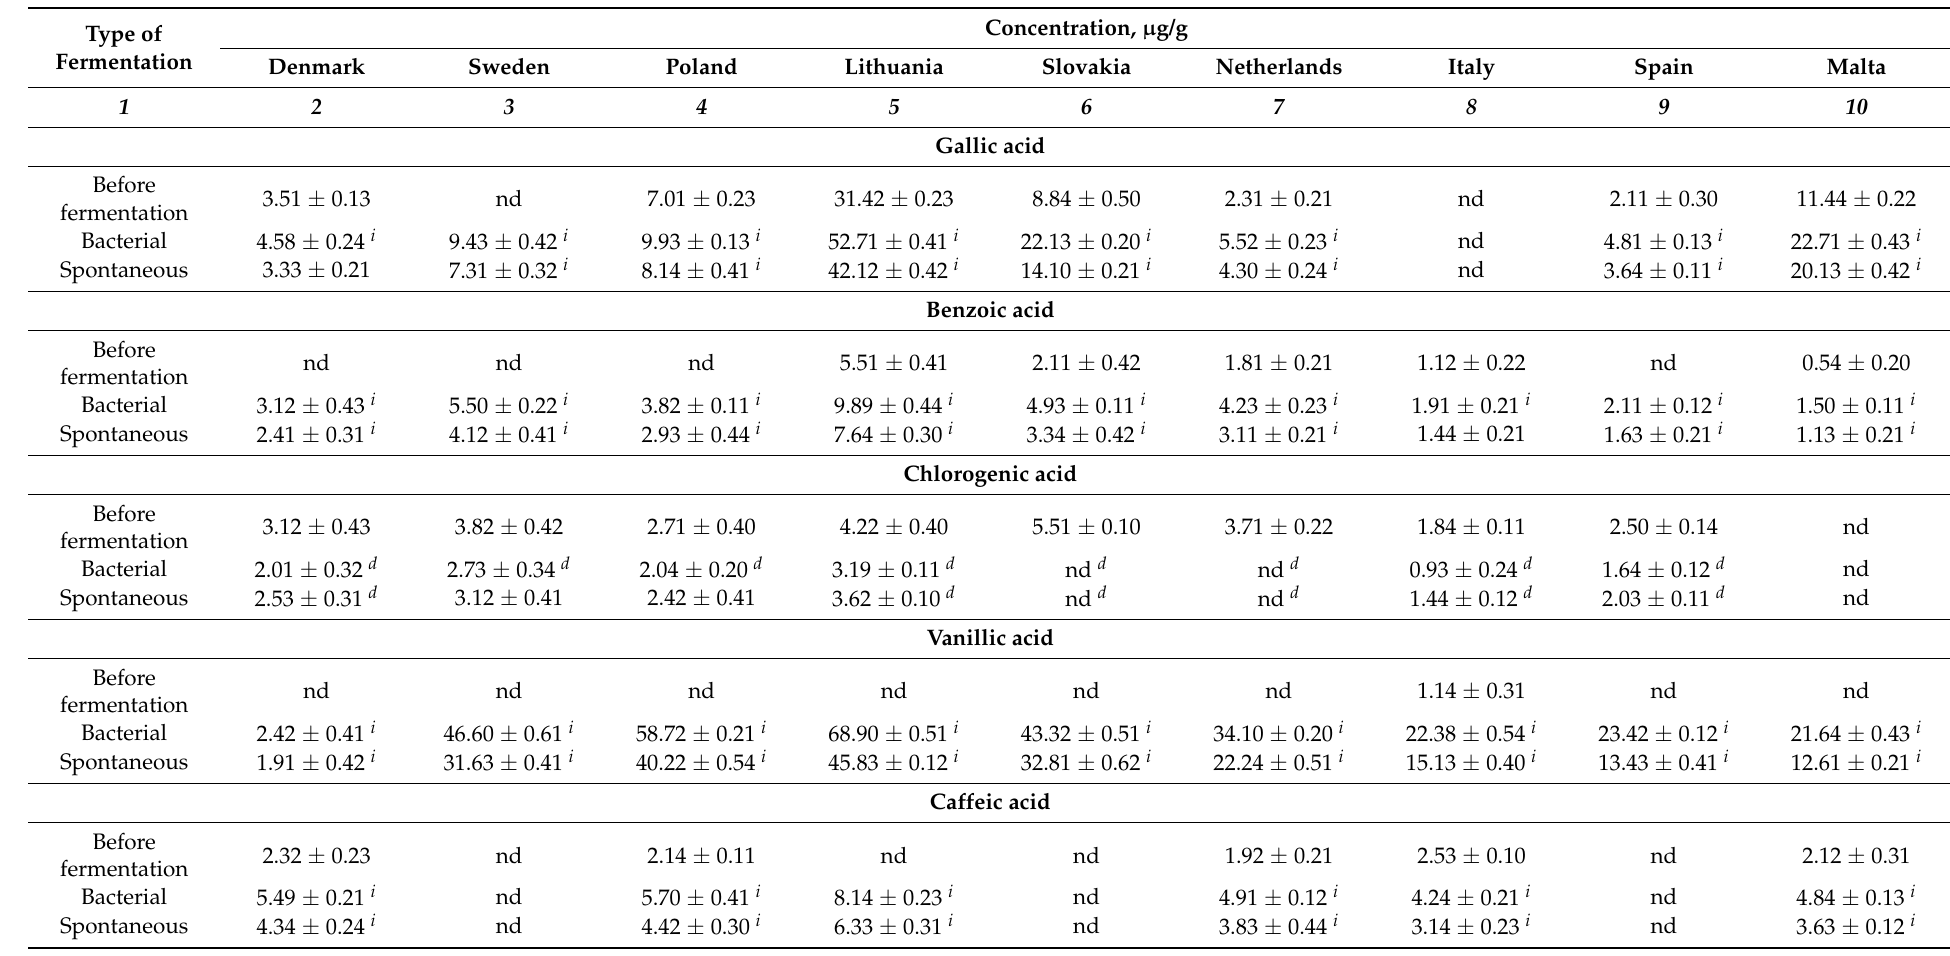
Table 5. Qualitative analysis results of polyphenolic compounds in natural and fermented pollen